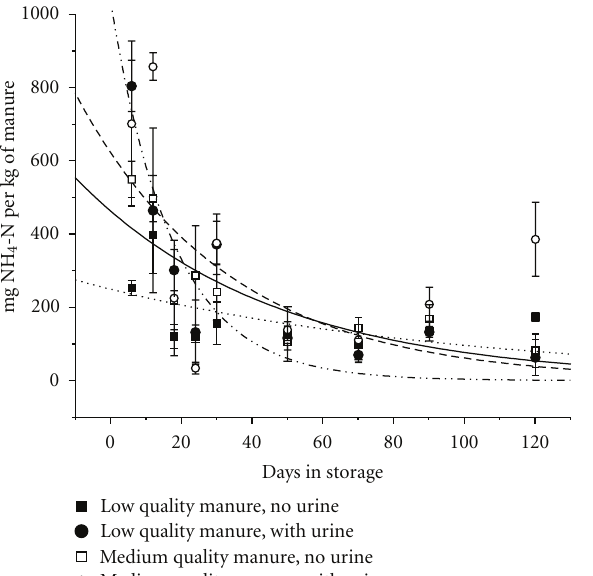
Figure 3: NH 4 -N dynamics in manure of the rainy season storage experiment. Error bars represent standard error of the mean values. Figure 2: NH 4 -N dynamics in manure of the dry season storage Continuous lines represent the best-fit regression equations for experiment. Error bars represent standard error of the mean values. NH 4 -N dynamics in manure during the dry season experiment. The Continuous lines represent the best-fit regression equations for solid line (—) represents the best-fit regression for the Medium NH 4 -N dynamics in manure during the dry season experiment. quality manure treatments. The dashed line (----) represents Y represents the amount of NH the best-fit regression for the Low quality manure treatments. Y 4 -N (mg/kg manure DM) in the manure. The solid line (—) represents the Medium quality represents the amount of NH 4 -N (mg/kg manure DM) in the manure, no urine treatment. The dashed line (----) represents manure. Medium quality manure: Y = 144 . 7 e 0 . 0349 x , R 2 = 0 . 508. the urine-amended Medium quality manure treatment. The dotted Low quality manure: Y = 240 . 7 e 0 . 0201 x , R 2 = 0 . 571. The rate line ( ···· ) represents the Low quality manure, no urine treatment. equations for NH 4 -N dynamics between the manure sources did not The dot-dash line (- ·· - ·· ) represents the urine-amended Low di ff er at significance level α = quality manure treatment. Medium quality manure, no urine: Y = 462 . 3 e − 0 . 0180 x , R 2 = 0 . 807. Medium quality manure, with urine: Y = 621 . 8 e − 0 . 0232 x , R 2 = 0 . 619. Low quality manure, no urine: Y = 249 . 1 e − 0 . 00955 x , R 2 = 0 . 715. Low quality manure, with urine: Y = 1033 . 7 e − 0 . 0570 x , R 2 = 0 . 812. The rate equations for NH 4 -N dynamics between the manure sources did not di ff er at significance level α = 0.05.